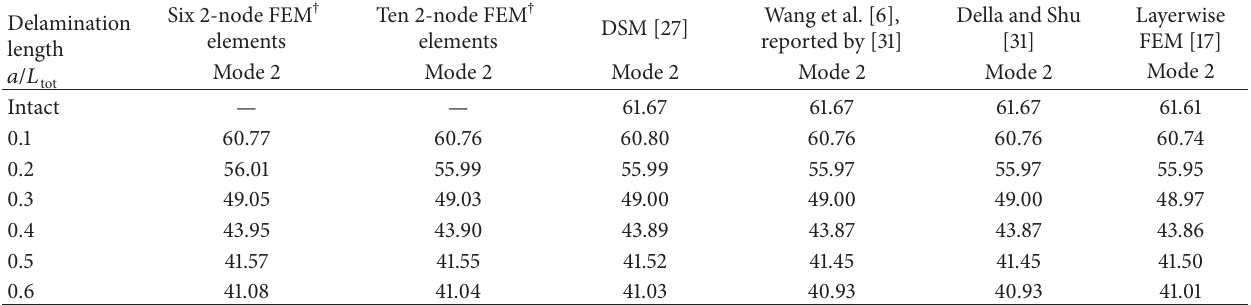
Table 2: 2nd frequency ( 𝜆 2 ) of the delaminated beam, with a split occurring symmetrically about the midsection along the midplane; proposed FEM, DSM, CM, and standard FEM